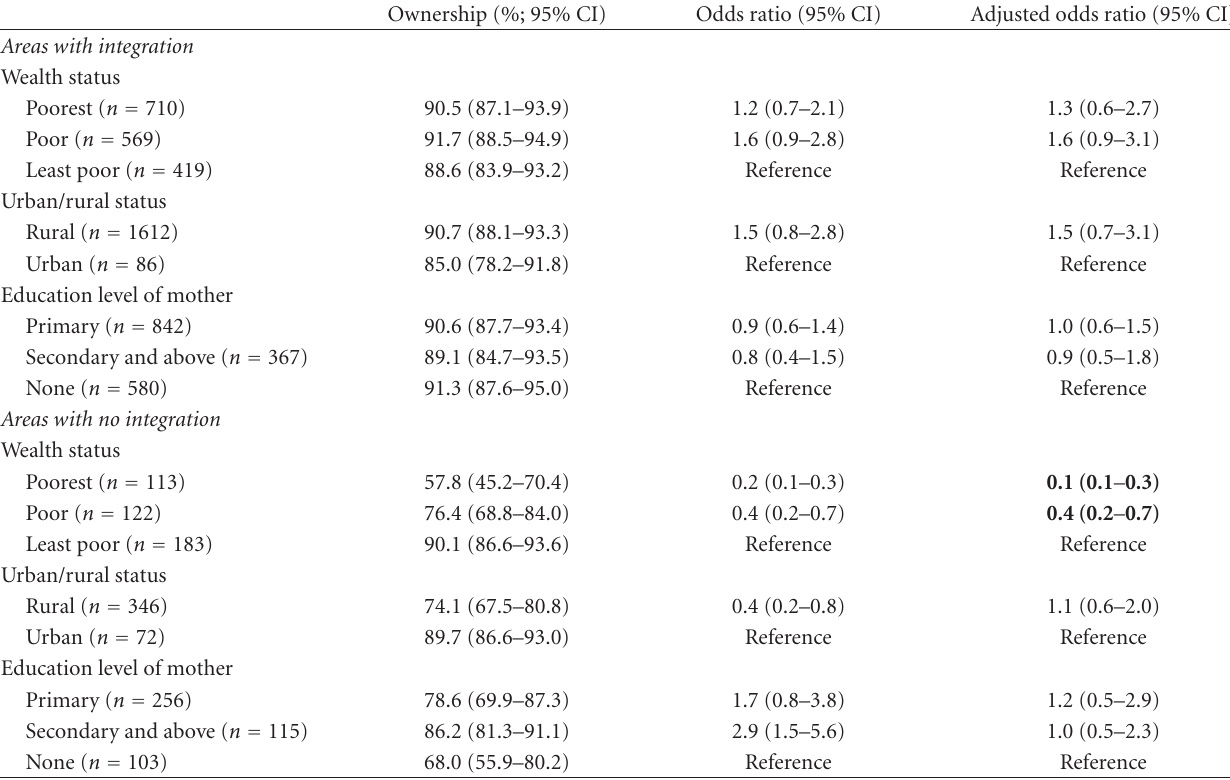
1 Abbreviations: CI = confidence interval 2 Significant adjusted odds ratios are indicated in